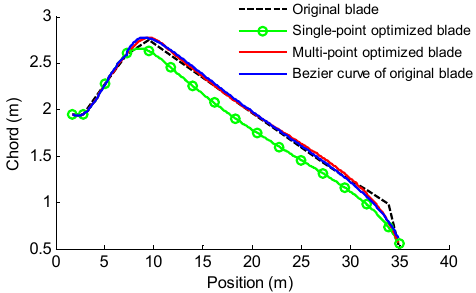
Figure 8. Chord distributions of the optimized and the original blades.